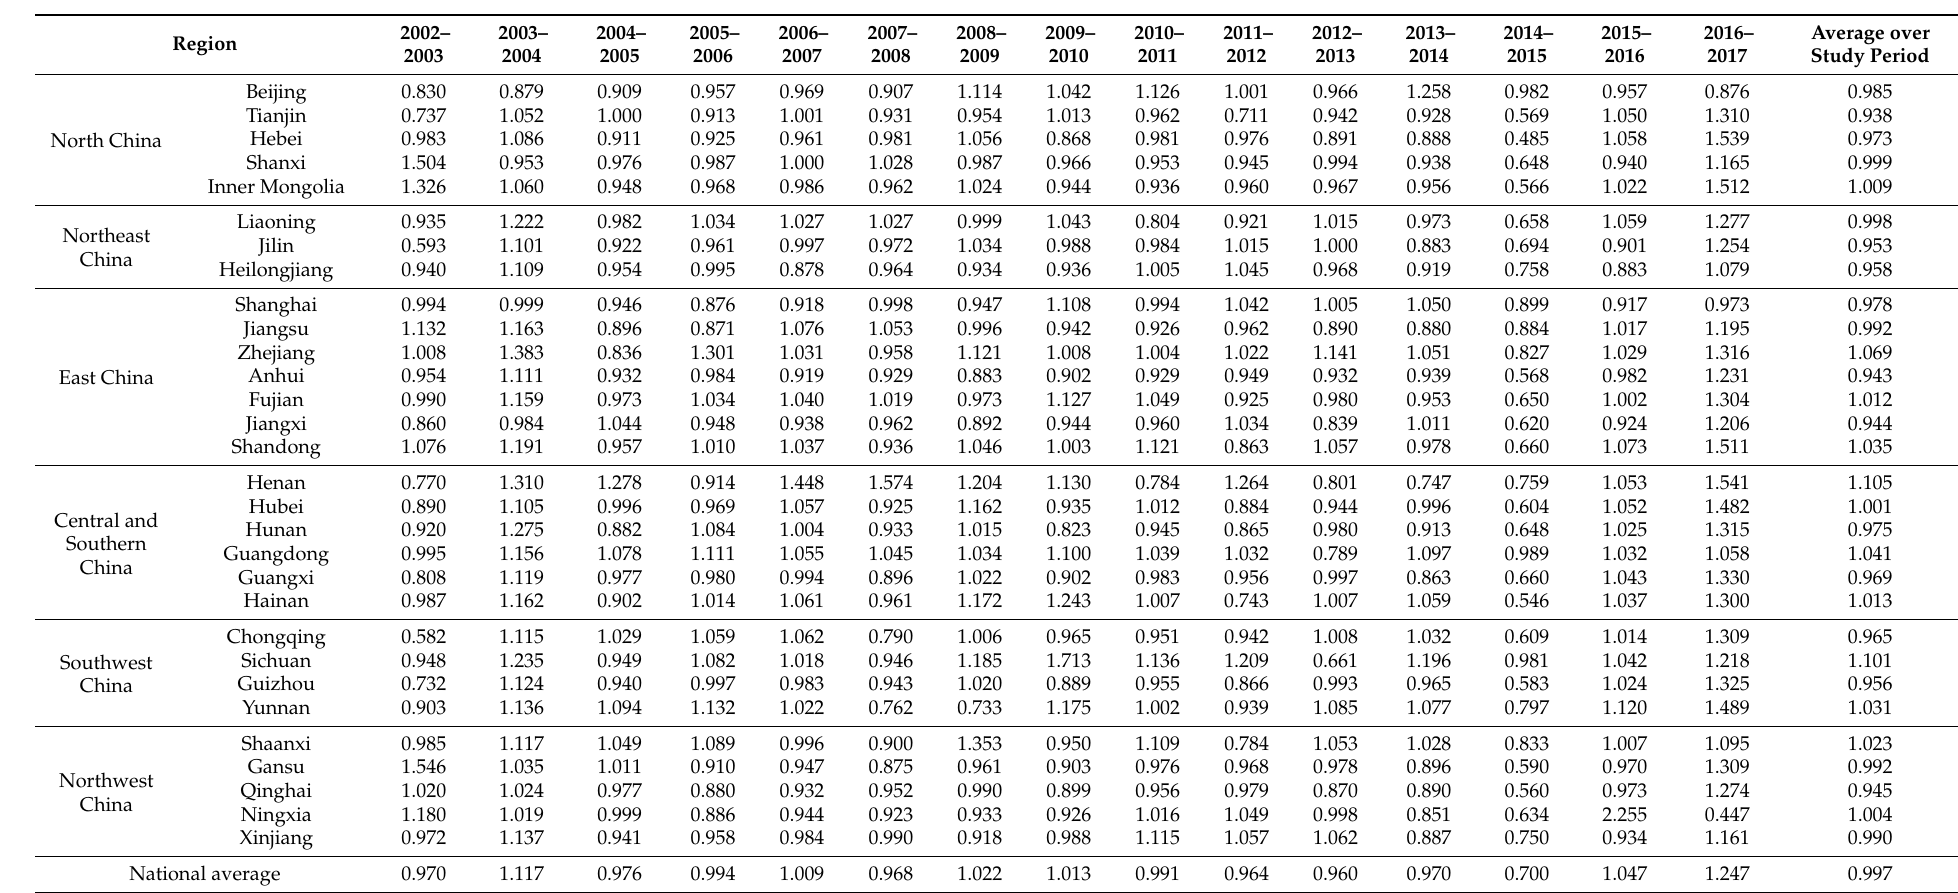
Table A3. Changes of bootstrapped TFPI over